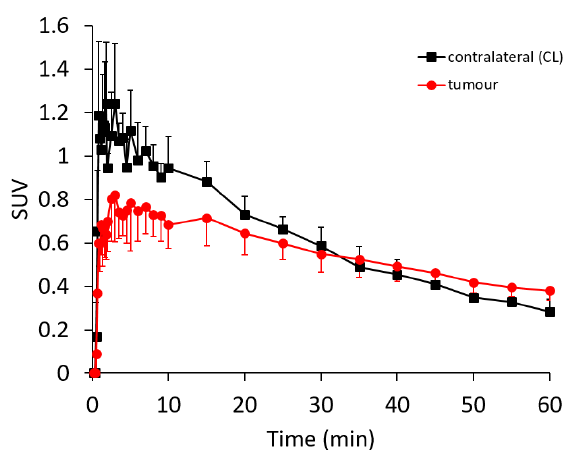
Figure 4. PET / MR imaging of sig1R in mice with orthotopic xenograft of human GBM cells (U87-MG). Average time-activity curves after i.v. administration of (S)-( − )-[ 18 F]fluspidine of the tumour (red dots) and the contralateral (black squares) regions of interest ( n = 3). Statistical test: Student t -test, * p < 0.05.